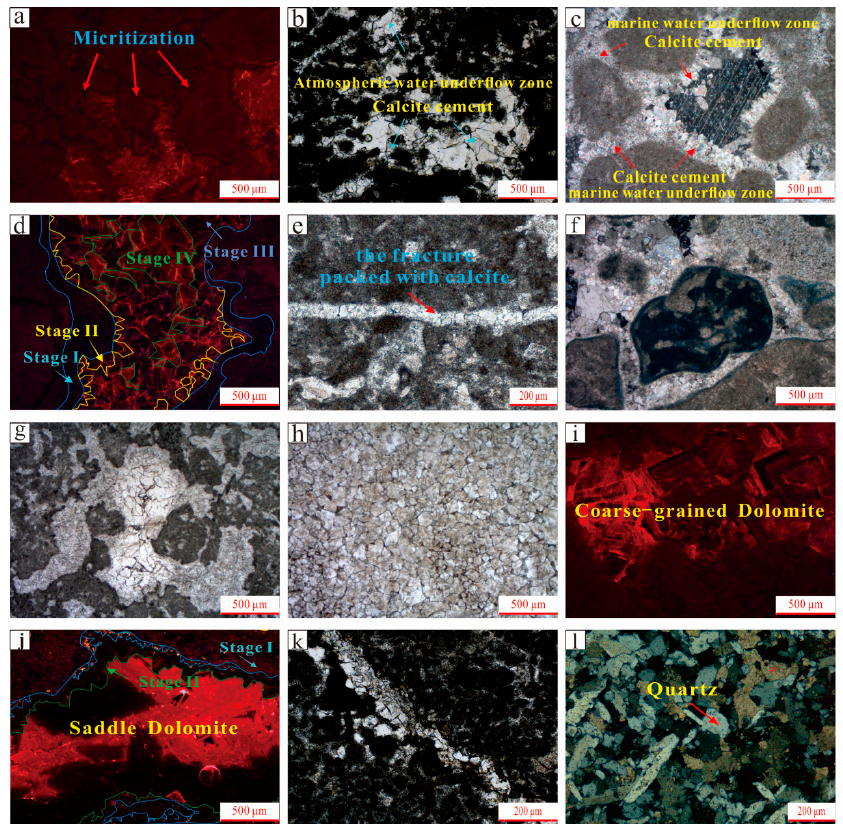
Figure2. TypicaldiagenesistypesoftheMiddle-LowerOrdoviciancarbonate. ( a )SN6, 7325.50m, sparry Figure 2. Typical diagenesis types of the Middle ‐ Lower Ordovician carbonate. a. SN6, 7325.50 m, dolomitized calcarenite, small scale, cathodoluminescence; ( b ) SN4, 6361.13 m, micrite calcarenite, sparry dolomitized calcarenite, small scale, cathodoluminescence; b. SN4, 6361.13 m, micrite plane polarized light; ( c ) SN6, 7325.50 m, sparry dolomitized calcarenite, plane polarized light; ( d ) SN6, 6849.50 m, micrite clastic limestone, cathodoluminescence; ( e ) SN1, 6639.70 m, micrite calcarenite, plane polarized light; ( f ) SN7, 6876.40 m, sparry calcarenite, plane polarized light; ( g ) SN6, 6849.50 m, micrite calcarenite, plane polarized light; ( h ) SN6, 7318.50 m, sand cutting fine crystalline dolomite, plane polarized light; ( i ) SN6, 7319.43 m, fine-medium crystal residual sandy dolomites, cathodoluminescence; ( j ) SN7, 6534.10 m, micrite clastic limestone, cathodoluminescence; ( k ) SN4, 6461.00 m, micrite calcarenite, plane polarized light; ( l ) SN4, 6673.22 m, siliceous limestone, orthogonal